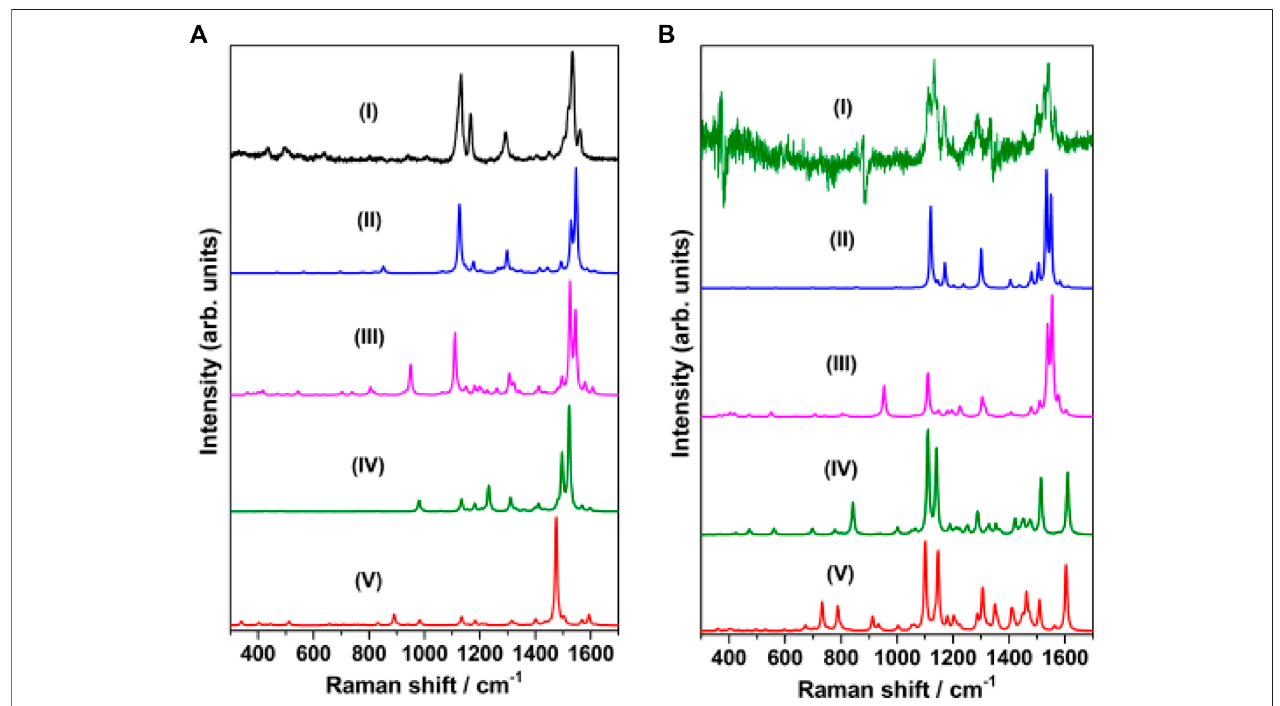
FIGURE 5| (A) Raman spectrum ofmerocyanine(I) solid, recorded at 785 nm excitation. B3LYP/6 – 31+G* computed Raman spectrum of(II) trans -MCH + , (III) cis - MCH + , (IV) trans -MC and (V) cis -MC. (B) Raman spectrum of merocyanine (I) in acetonitrile, recorded at 785 nm excitation. B3LYP/6 – 31+G* computed Raman spectrum (in acetonitrile) of (II) trans -MCH + , (III) cis -MCH + , (IV) trans -MC and (V) cis -MC.